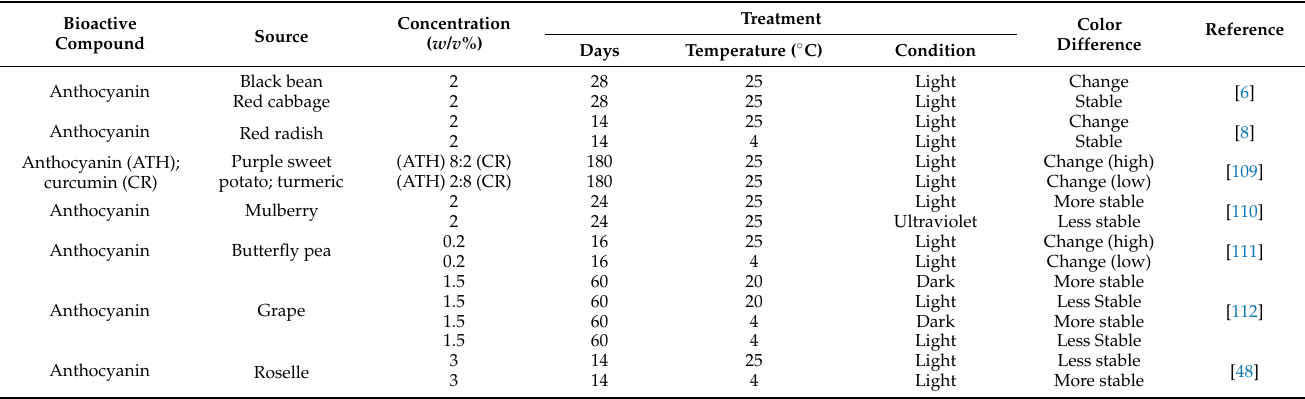
Table 1. Effect of color stability using various sources of natural extract for the application of film packaging as a color